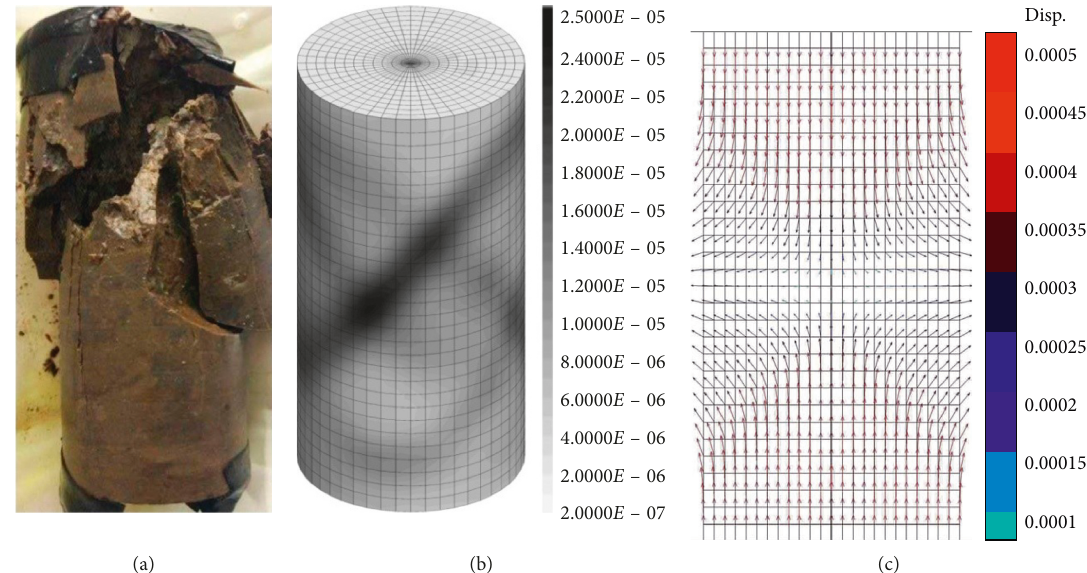
Figure 12: Failure forms in triaxial tests and simulations (rock mass, σ Displacement vector.